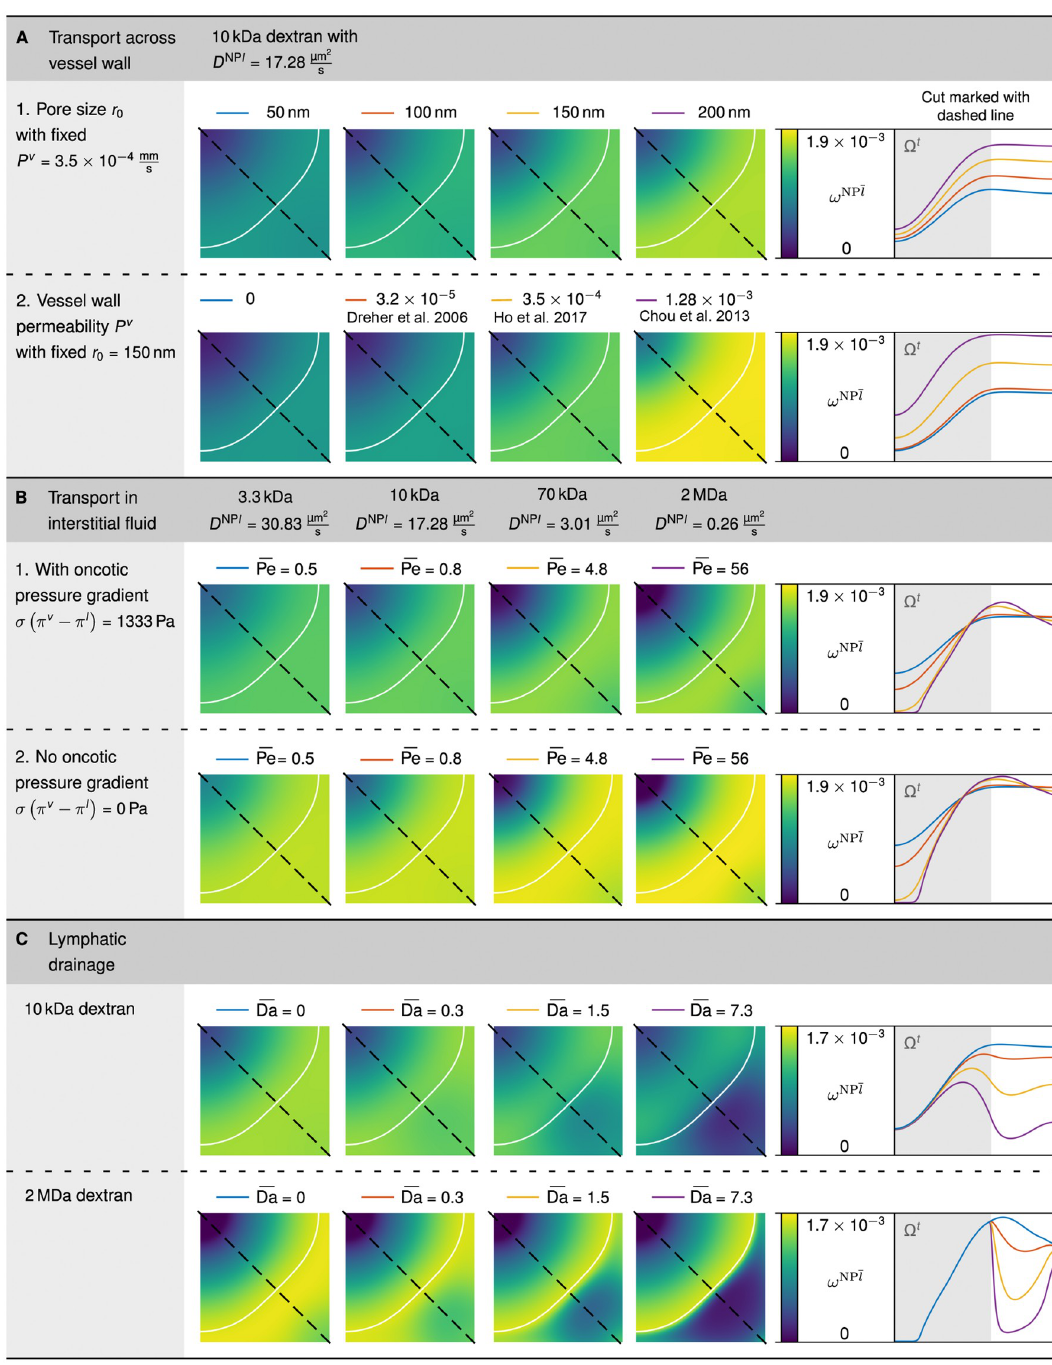
Fig 6. Nanoparticle distribution in the interstitial fluid o NP � l after a 20 min injection period. (A) Influence of transport across vessel walls via the inter- and the transendothelial pathway. (B) Influence of transport characteristics in the interstitial fluid with different Pe´clet numbers. (C) Influence of lymphatic drainage with different Damko¨hler numbers.